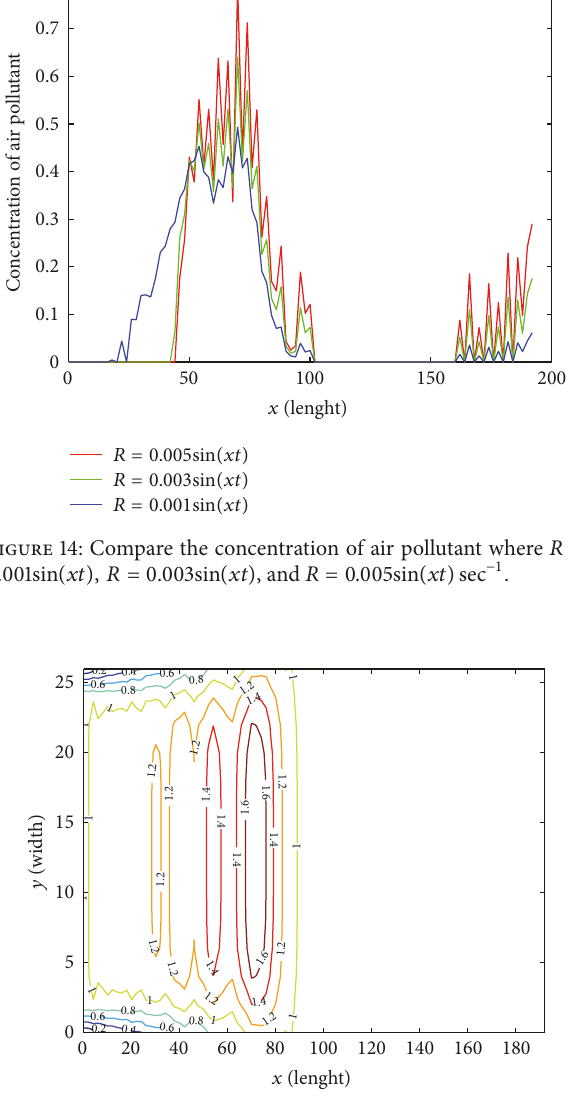
𝑅 = 0.00 1sin (𝑥𝑡) (source-sink) and 𝑅 = 0.003| sin (𝑥𝑡)| (source), respectively. Figures 14 and 17 compare the air pollutant concentration levels where 𝑅 is the constant in the first case and second case of Simulation B, respectively.